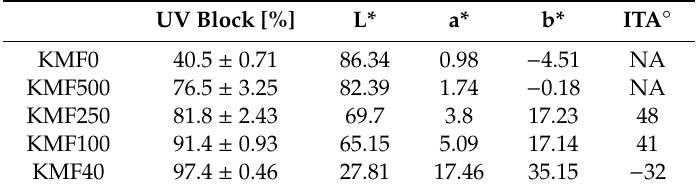
Table 2. Percent of UV blocked, CIE L*a*b* values, and individual typology angle (ITA) ◦ values of